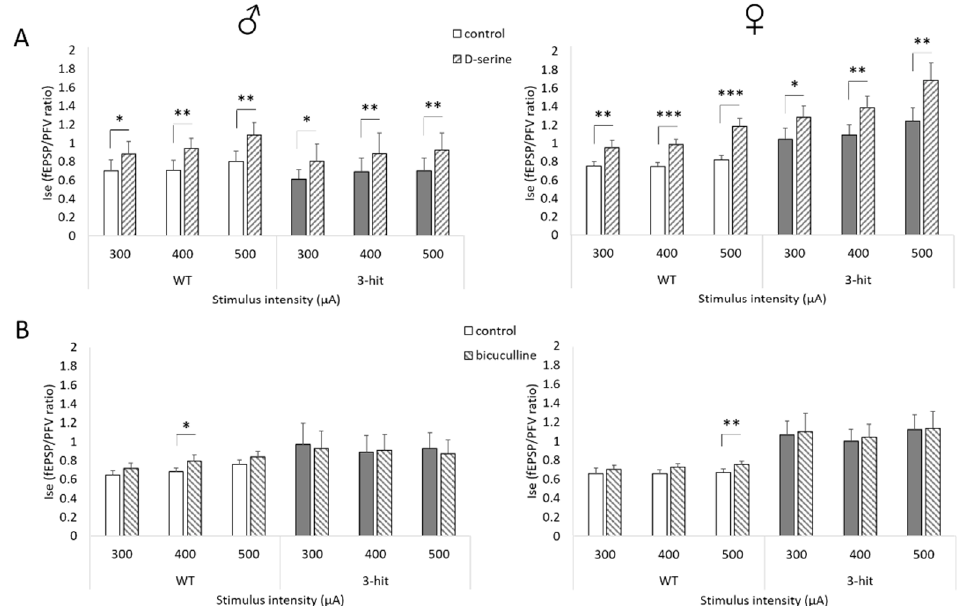
Figure 4. Responsiveness of NMDAr activation to bicuculline but not D-serine is altered in 3-hit mice. ( A ) Index of NMDAr-mediated synaptic efficacy Ise (fEPSP/PFV ratio) determined in slices from WT and 3-hit male (left) and female (right) mice, with increasing stimulus intensity, in control vs. D-serine supplemented artificial cerebrospinal fluid (aCSF) (males: WT: n = 18 slices vs. 3-hit: n = 20 slices; females: WT: n = 12 slices vs. 3-hit: n = 10 slices). ( B ) Index of NMDAr-mediated synaptic efficacy Ise (fEPSP/PFV ratio) determined in slices from WT and 3-hit male (left) and female (right) mice, with increasing stimulus intensity, in control vs. bicuculline supplemented aCSF (males: WT: n = 11 slices vs. 3-hit: n = 9 slices; females: WT: n = 13 slices vs. 3-hit: n = 12 slices). Represented data are Mean ± SEM; Paired t-tests or Wilcoxon paired t tests, *: p < 0.05; **: p < 0.01; ***: p < 0.001.